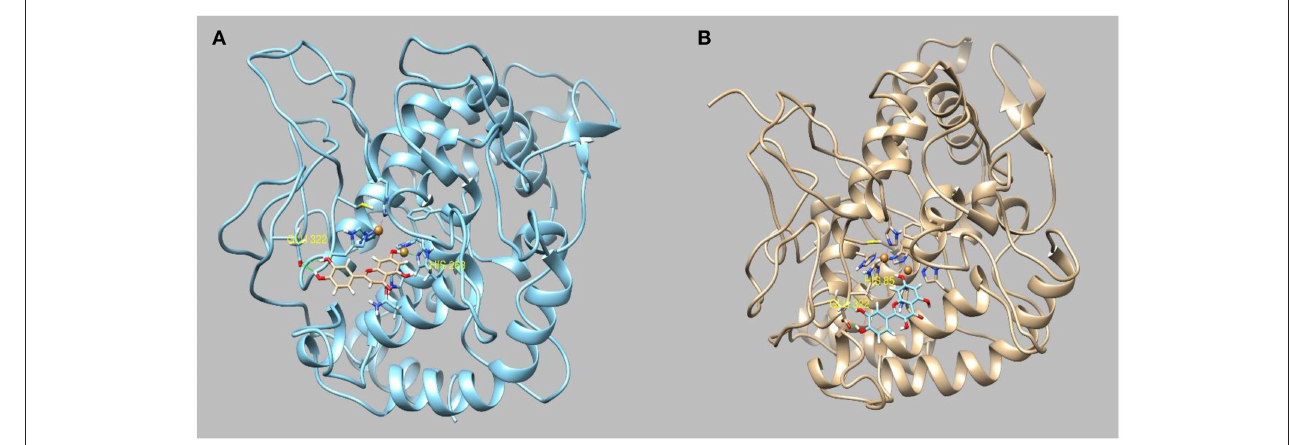
FIGURE 4 | Best pose of (A) luteolin and (B) quercetin docked to tyrosinase.